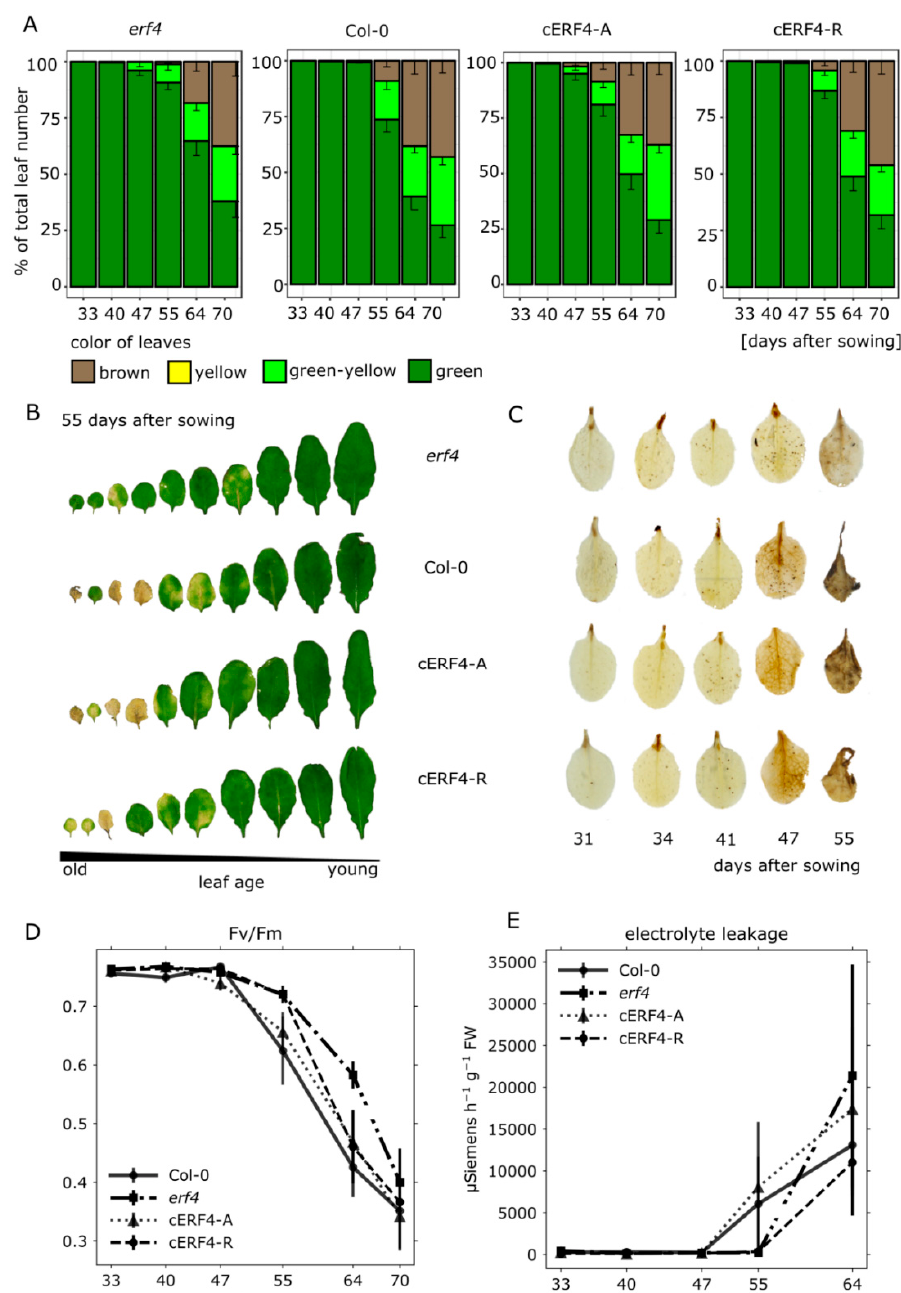
Figure 3. Complementation of ERF4 loss of function by ERF4-A or ERF4-R. Senescence phenotype and parameters were analyzed in Col-0, erf4 mutants, and erf4 mutant plants complemented with either ERF4 -promoter: ERF4-A (cERF4-A) or ERF4 -promoter: ERF4-R constructs (cERF4-R). ( A ) Automated colorimetric assay, in which rosette leaves are categorized according to color in four groups (green, green-yellow, yellow, brown). ( B ) Representative pictures of rosette leaves No. 1–10, which were sorted according to leaf age 55 DAS. ( C ) One representative picture of five biological replicates for DAB-staining in leaf No. 4 at 31–55 DAS. These plants have been raised under normal light intensities (80 µ E/m2/s). ( D ) Fv/Fm values in rosette leaves were measured with pulse amplitude modulation (PAM). ( E ) Electrolyte Leakage (EL) was measured with a conductivity meter in detached leaves No. 4 of another experimental series. Values are normalized to fresh weight. Data A, D and E represent means of at least four biological replicates, error bars indicate ±SE.